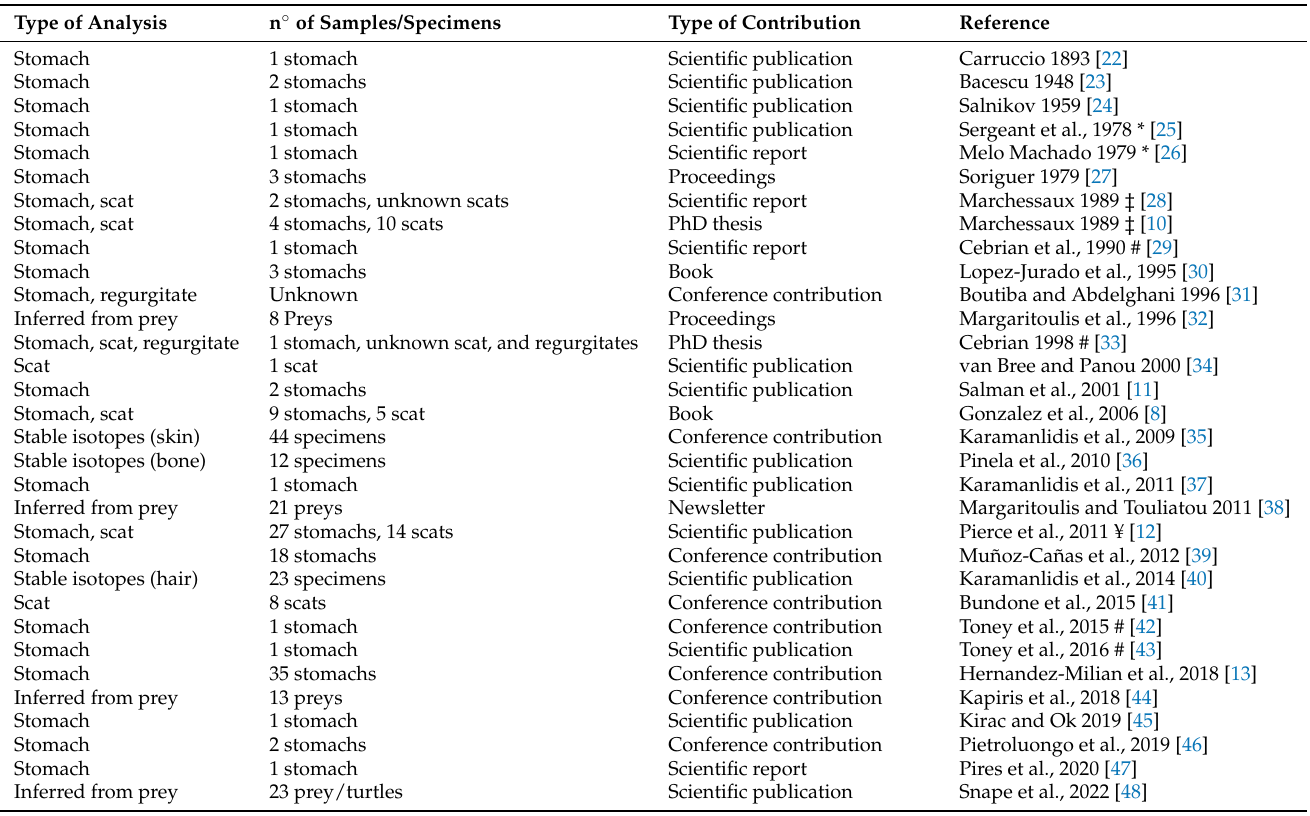
Table 2. Review of Mediterranean monk seal feeding ecology studies.